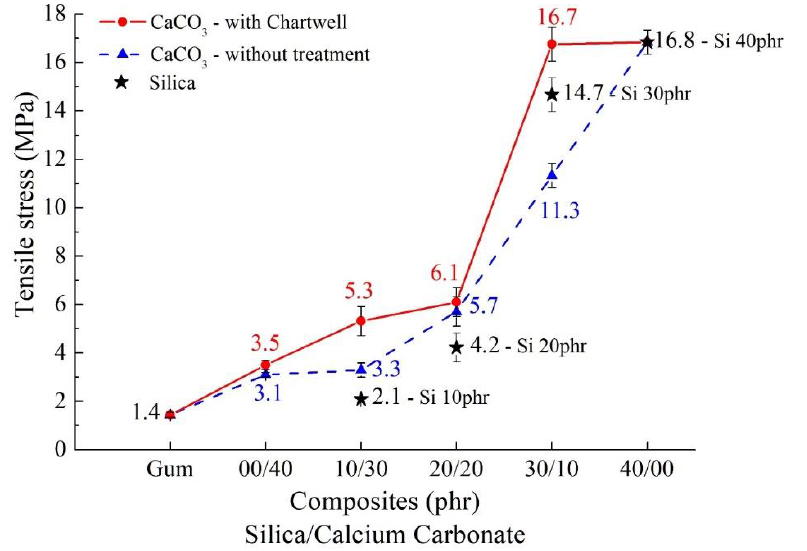
Figure 8. Tensile strength test results (at a deformation speed of 500 mm min − 1 and a load cell of 1000 kN) of the hybrid composites of NR with silica (SiO 2 + Si69 ® ) and calcium carbonate (CaCO 3 ) treated with 2% Chartwell ® . The first composite is gum, and the silica composite (SiO 2 + Si69 ® ) was used as a reference point for comparison.